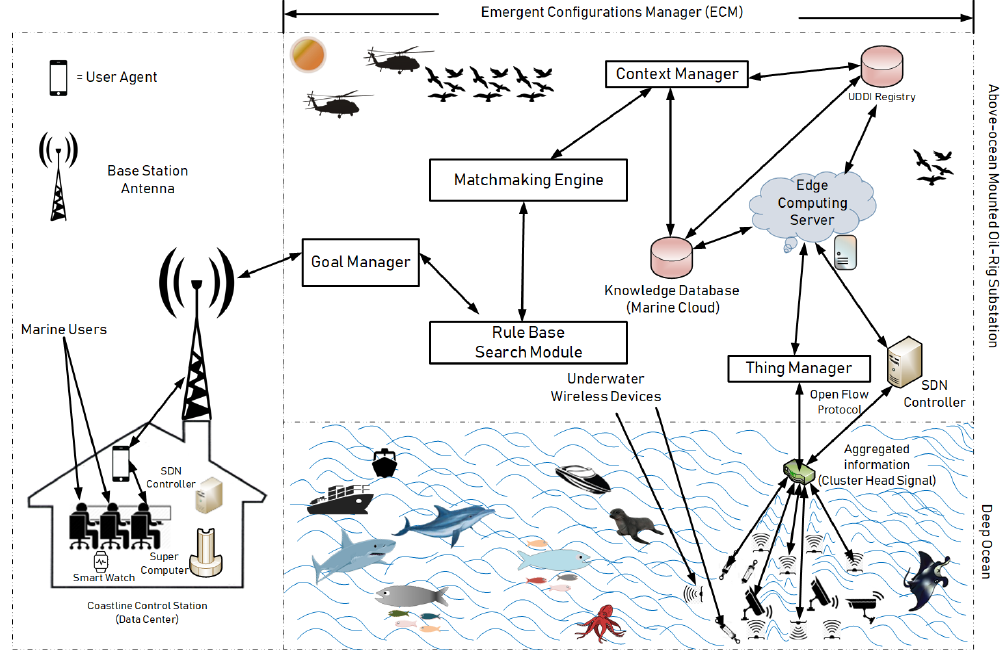
Figure 7. Proposed ubiquitous computing-aided SDN-based EC architecture for maritime explorations.